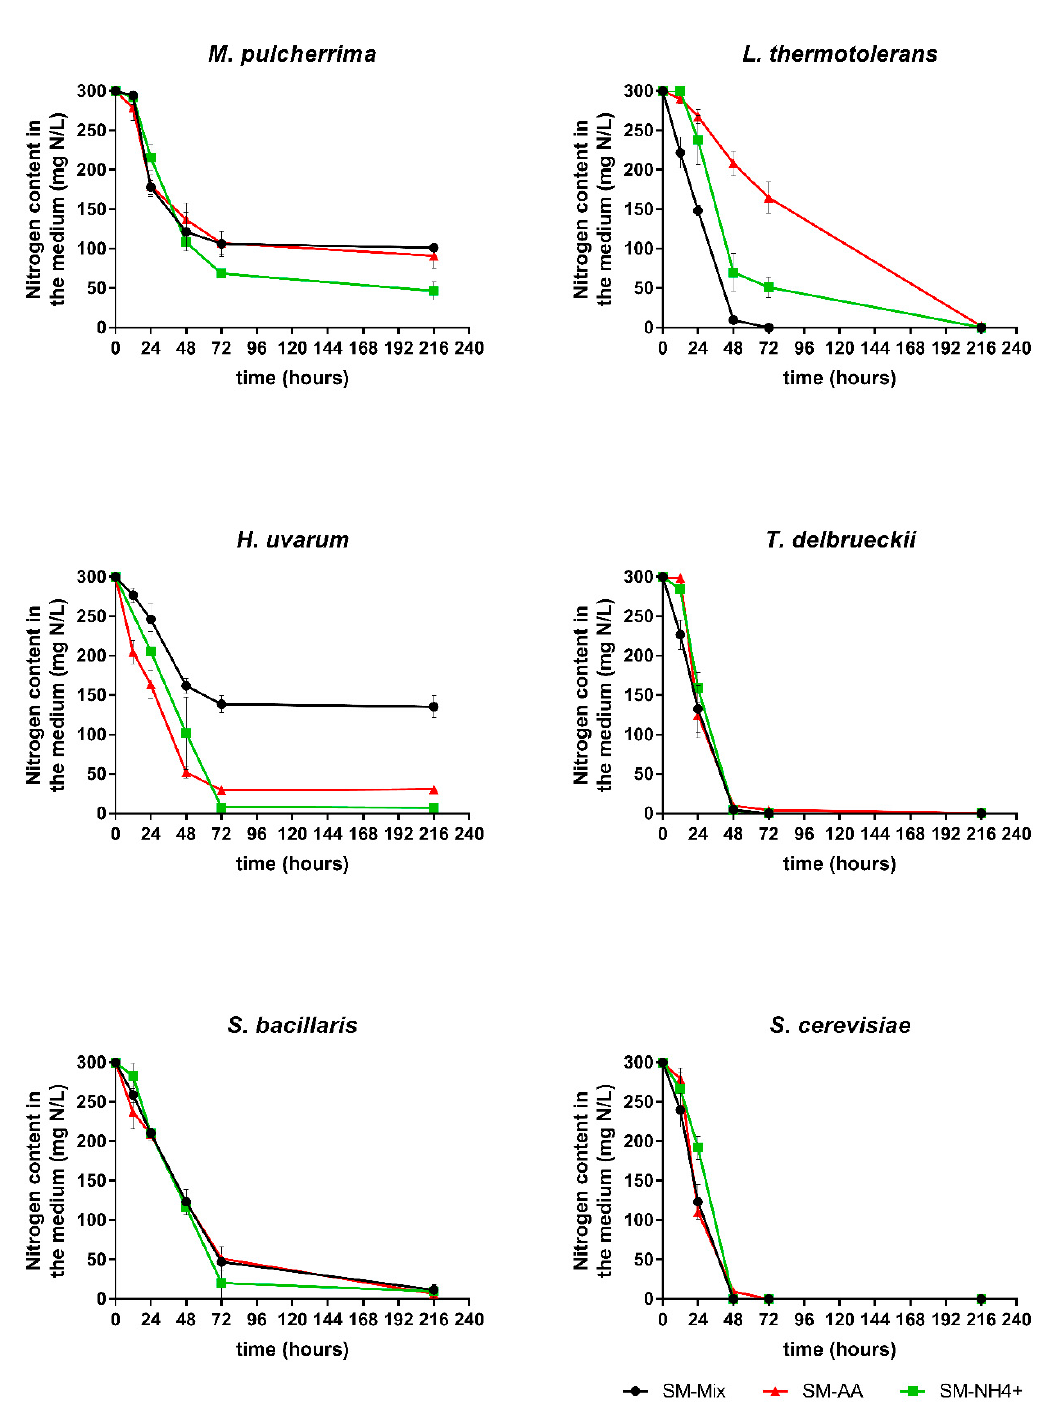
Figure 3. Nitrogen consumption (mg N / L) profiles of single fermentations in three di ff erent media: SM-Mix, SM-AA, and SM-NH 4 + . Error bars represent standard deviation.